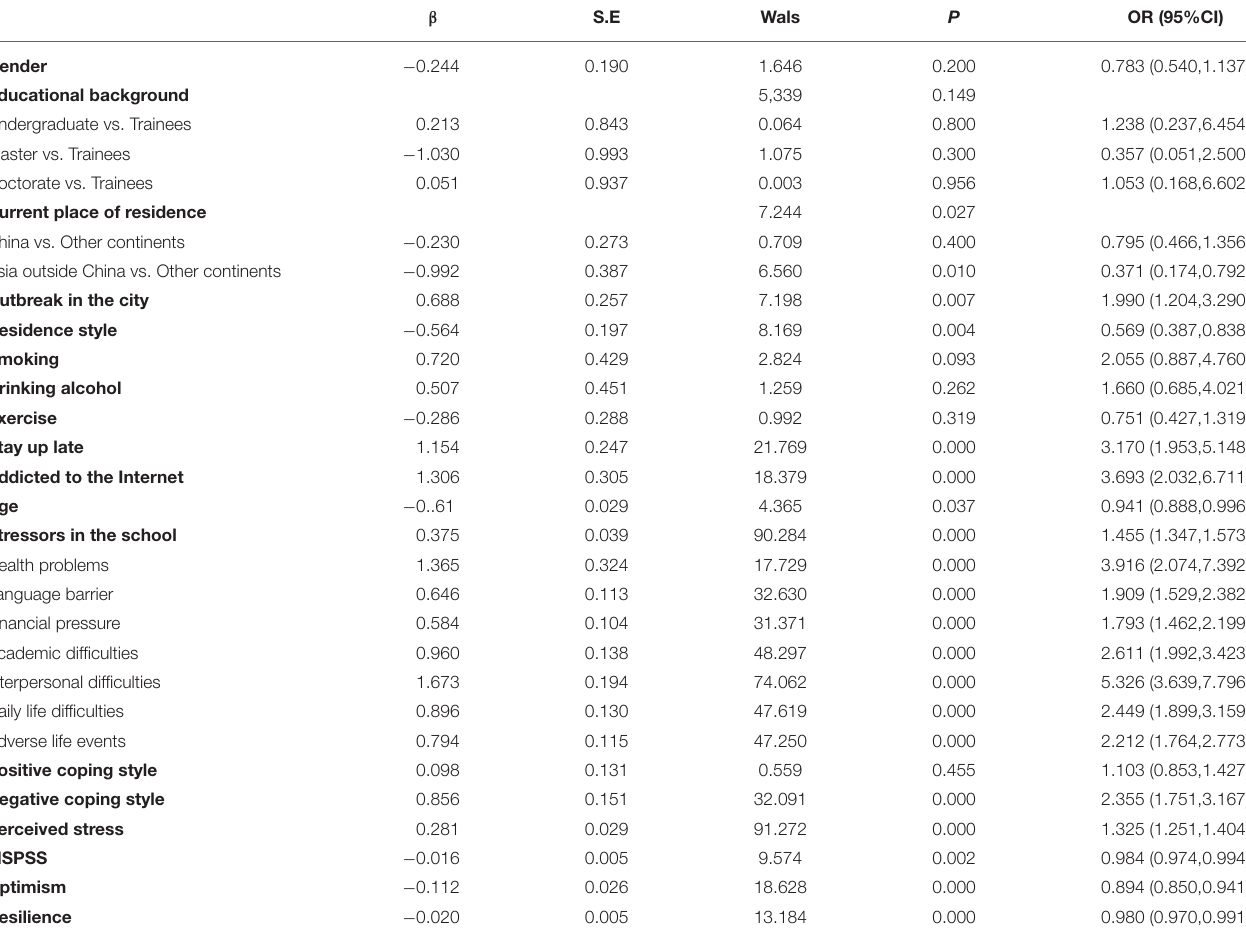
TABLE 3 | Univariate logistic regression analysis on results of depressive symptoms ( n = 519). β S.E Wals